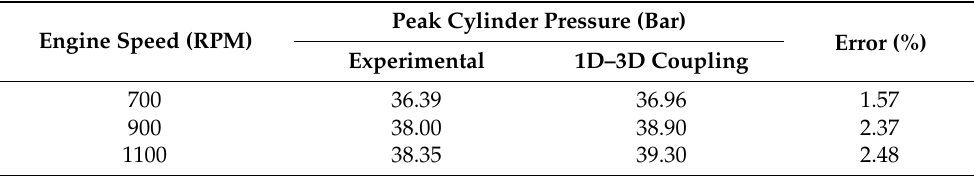
Figure 6. Cylinder pressure results of the 1D–3D coupling gas flow analysis and experiment. Table 1. Peak cylinder pressure results of the 1D–3D gas flow analysis and